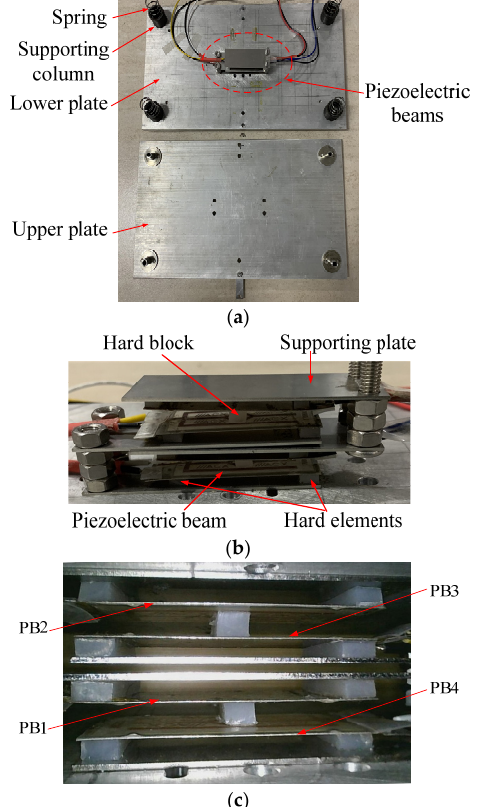
Table 1. Properties of the plates and the piezoelectric beams.